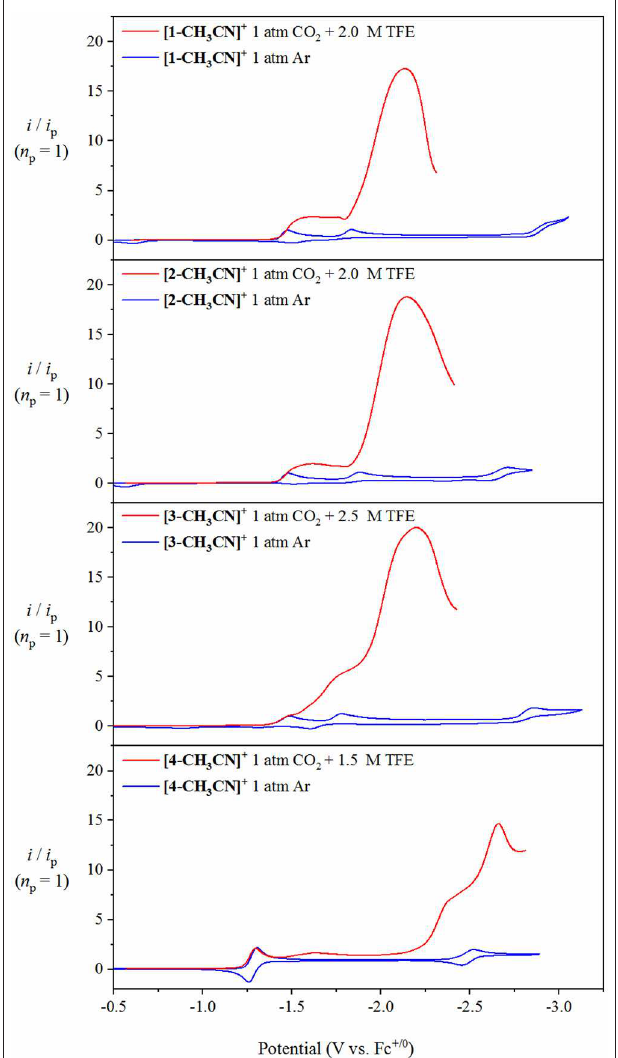
FIGURE 8 | Overlay of cyclic voltammograms for [1-CH 3 CN] + , [2-CH 3 CN] + , [3-CH 3 CN] + and [4-CH 3 CN] + recorded under 1 atm of Ar (blue), with respective linear sweep voltammetry recorded under 1 atm CO 2 in the presence of optimum TFE (red) at υ = 0.1V s − 1 with 0.1M [Bu 4 N][PF 6 ] acetonitrile supporting electrolyte. The current (y-axis) data are normalized with respect to the non-catalytic Faradaic response ( i p